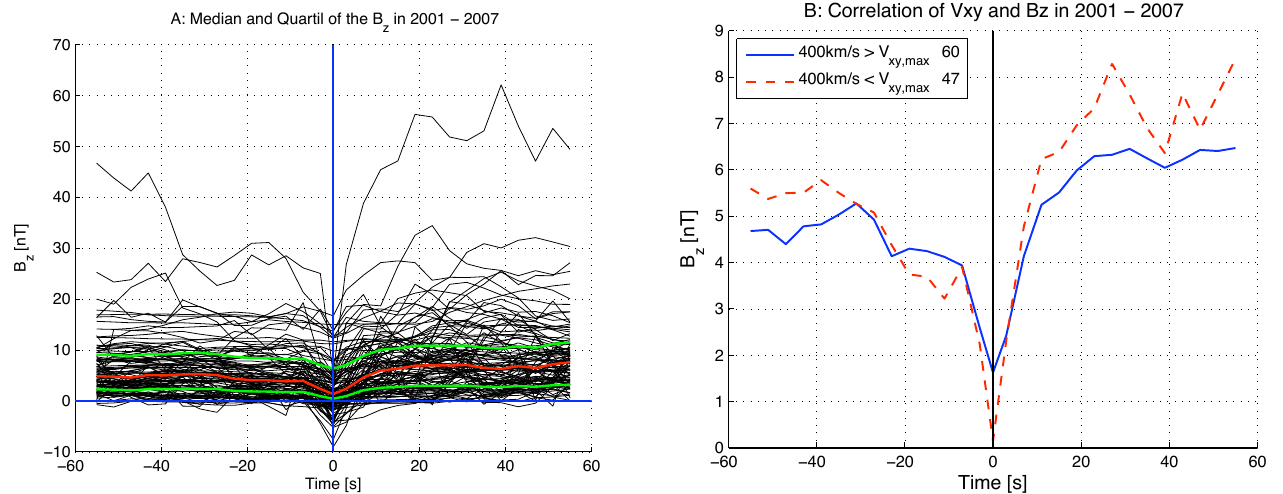
Fig. 3. The left figure shows the B z of the 107 dipolarization events (black line) and the median over these events (red line). The green lines are the upper and lower quartile of the median of B z . The right figure shows the relation between the maximum perpendicular plasma flow velocity in XY plane and the median of the superposed B z for the 107 events. From these 107 events 60 events had a maximum velocity in